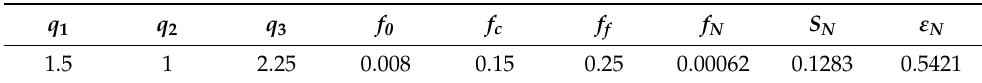
Table 2. GTN model parameters